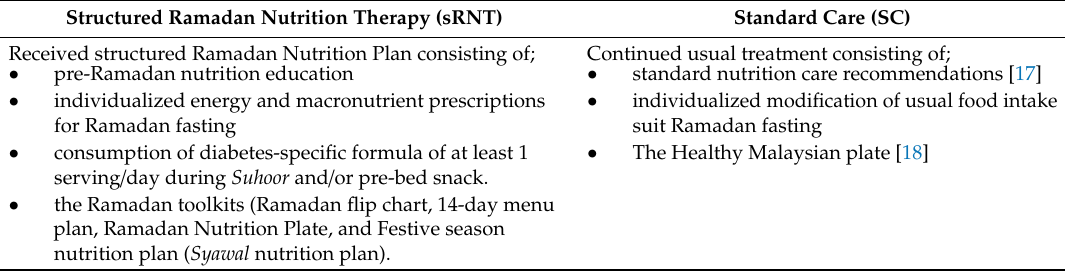
Table 1. A summary of nutrition strategies in structured Ramadan Nutrition Plan and Standard